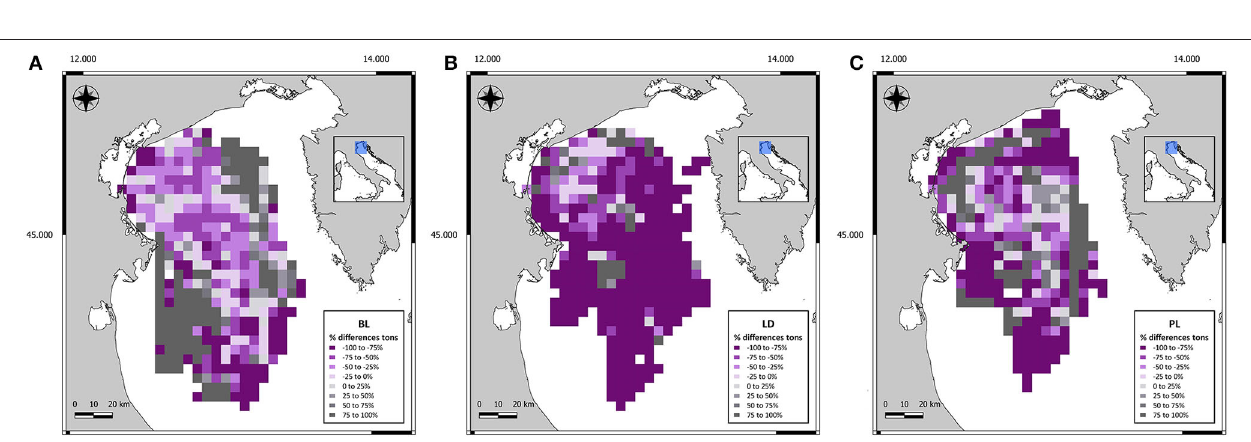
FIGURE 4 | Percentage differences between 2019 and 2020 during the three periods (BL: before lockdown, LD: lockdown, and PL: post-lockdown) considering the number of active vessels, the days at sea, the fishing effort (FE), landings, and profits of the Chioggia trawling fleet.